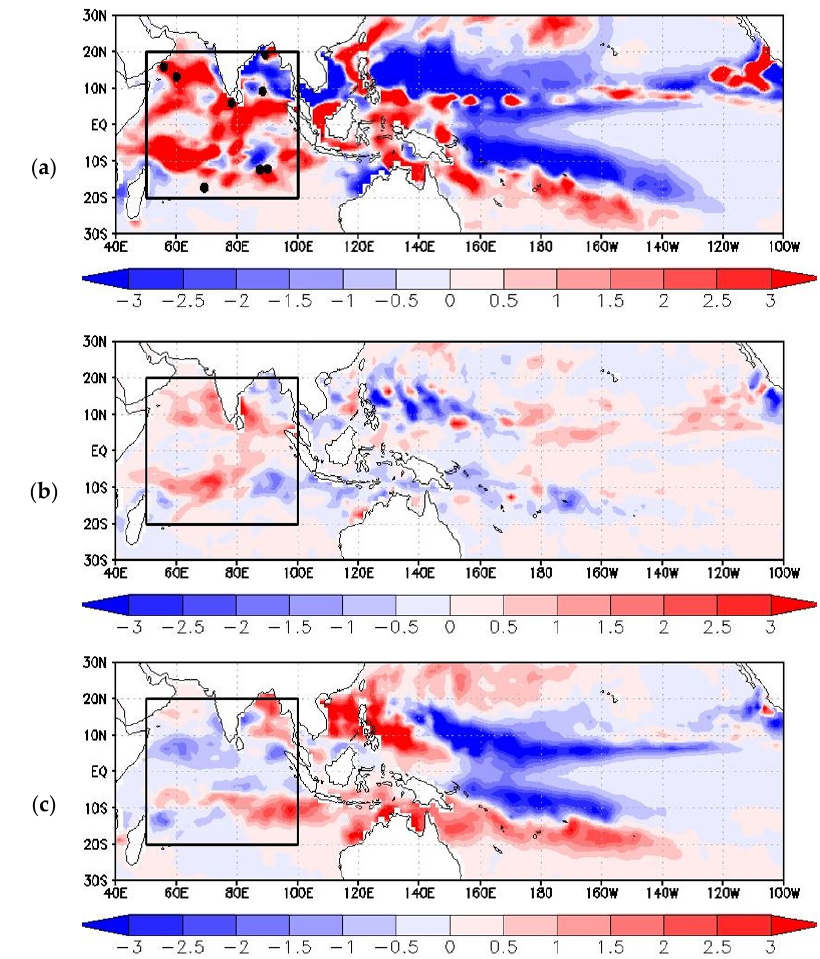
Figure 2. Genesis potential index (GPI) anomaly fields (color shading) ( a ) in the year 2011; ( b ) averaged in the MJO active years; and ( c ) averaged in the La Niña years. The solid box indicates the tropical Indian Ocean region. The black points in (a) denote the locations of TCG from October to December in 2011.